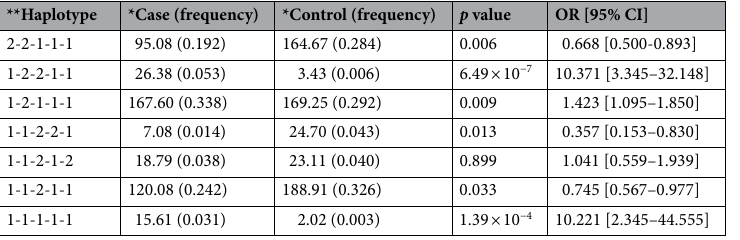
Table 2. Haplotype analysis of IVS2-74T>G, IVS2-16G>C, IVS2-666C>T, 3’UTR + 233G>C and 3’UTR + 314G>A in all races dataset with 249 cases and 294 controls. *Frequency < 0.03 in both controls and cases has been dropped in the analysis. ** Major allele is depicted as 1. Minor allele is depicted as 2. A sequential in allele combination represents for IVS2-74T>G, IVS2-16G>C, IVS2-666C>T, 3’UTR + 233G>C and 3’UTR + 314G>A